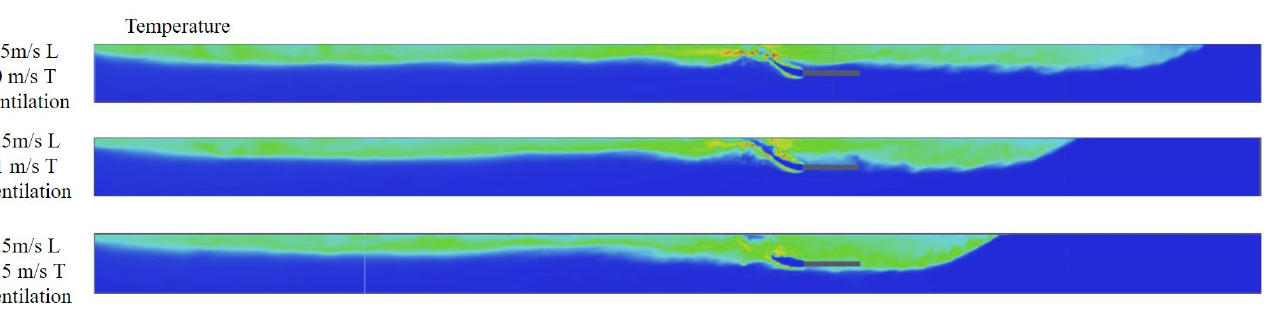
Figure 10. 2D temperature and velocity contour plots at 45 s—effect of the transverse ventilation velocity (Cases 2, 10 and 11). The colour code is the same as in Figure 7.